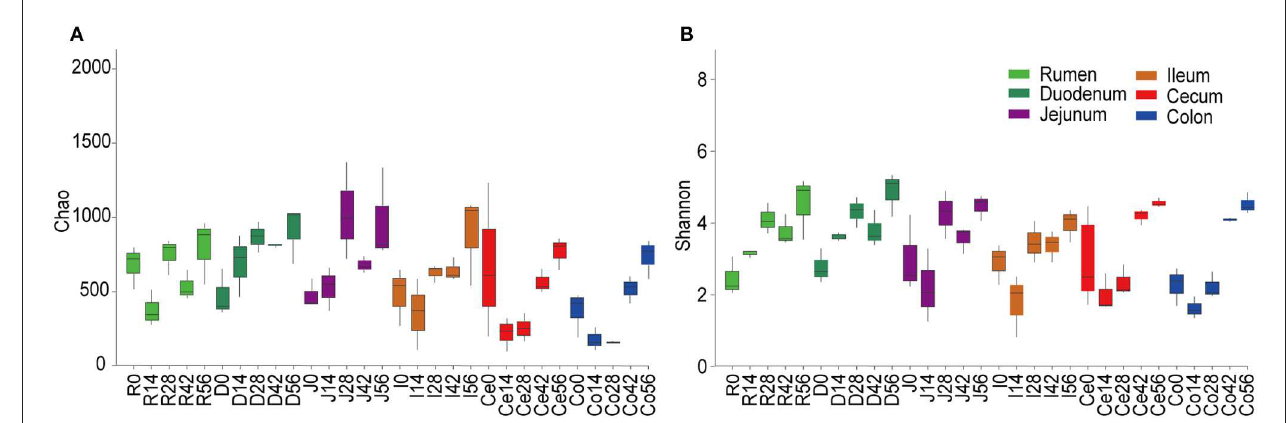
FIGURE 1 | Alpha diversity of the bacterial community within each age group across the gastrointestinal tract. The richness and diversity were calculated via Chao (A) and Shannon (B) indexes, respectively. Boxplots indicate significant differences among ages within a given GIT